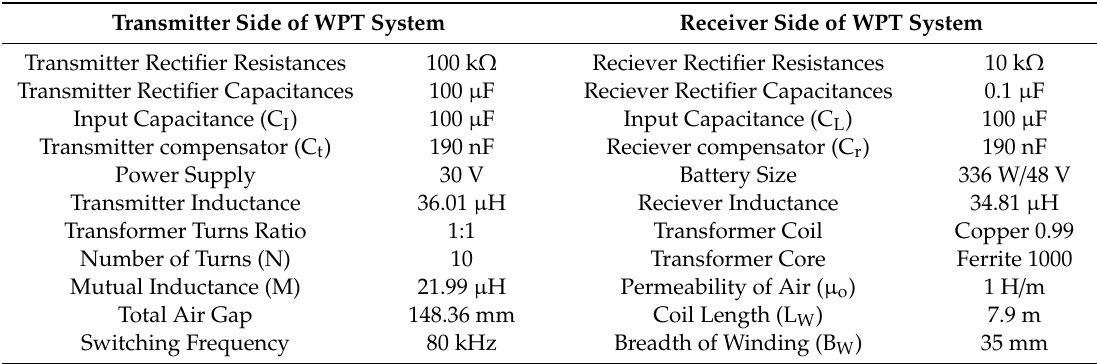
Table 1. Characteristics of WPT system